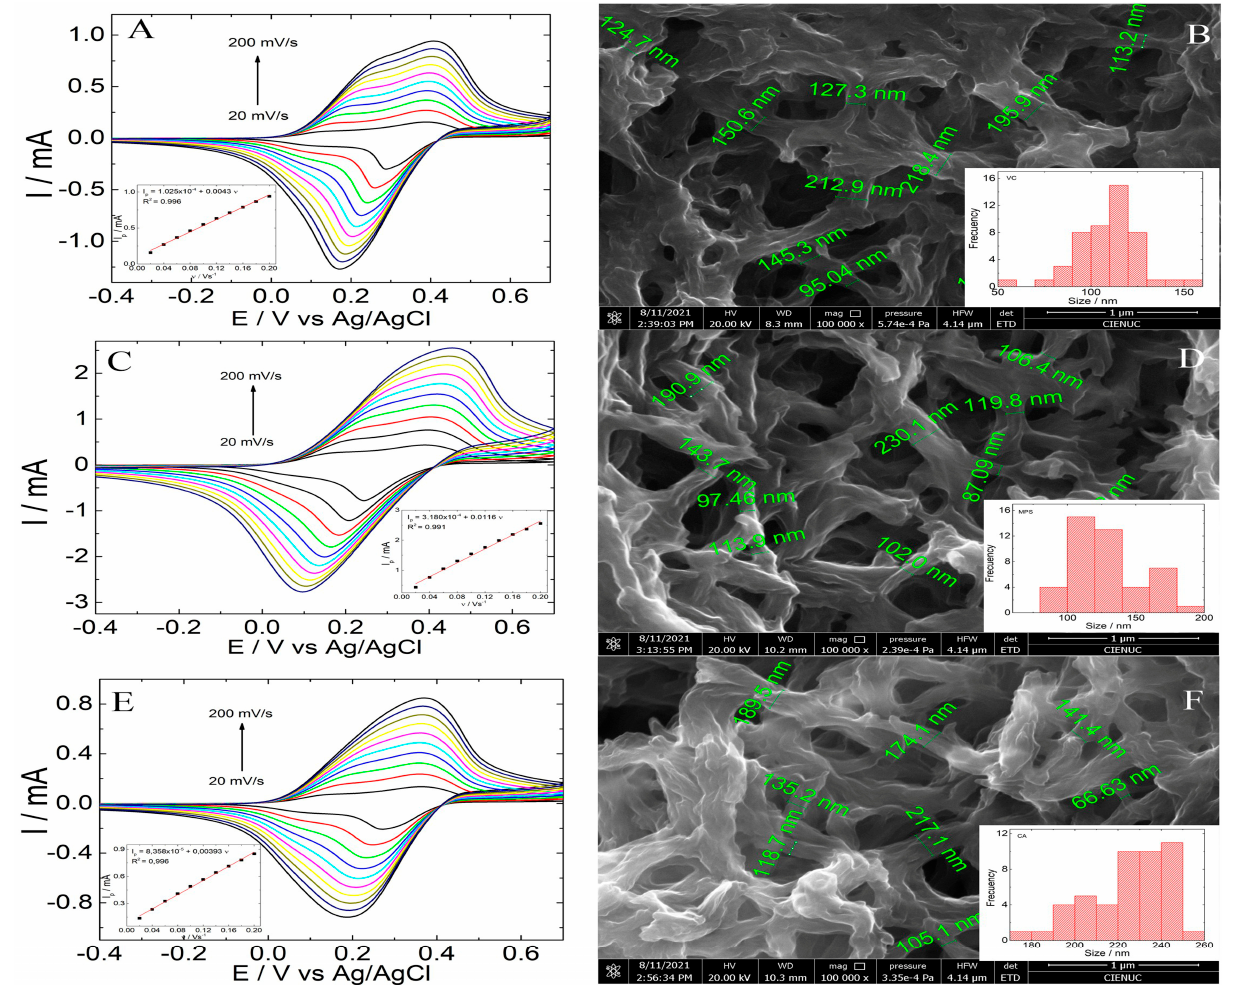
Figure 1. CV ( A , C , E ) in acetate buffer 0.1 mol · L − 1 (pH 4.75) at different scan rates of 0.2 V · s − 1 to 0.02 V · s − 1 and SEM images ( B , D , F ) of 6-PICA obtained through three different electrochemical techniques. Inset ( A , C , E ): the linear relationships of the anodic peak current depended on different scan rates. Inset ( B , D , F ): histogram showing the nanowire size distributions of